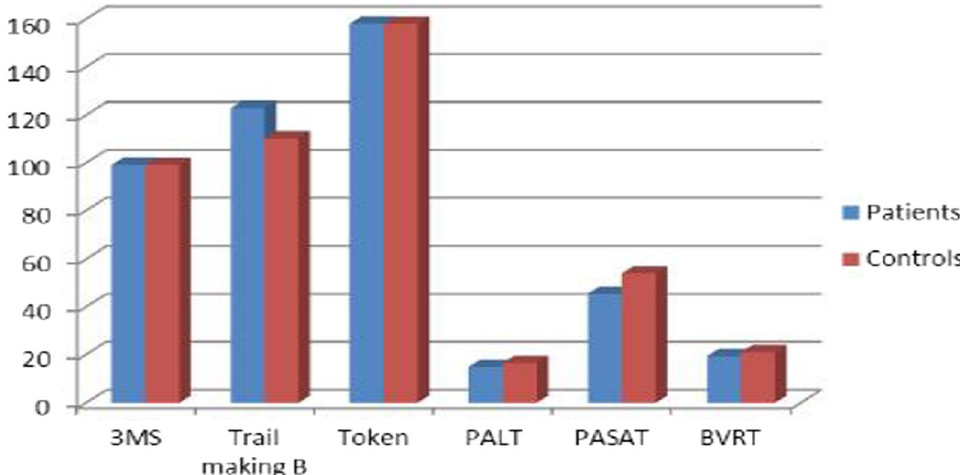
Fig. 1 Cognitive assessment in patients and control groups